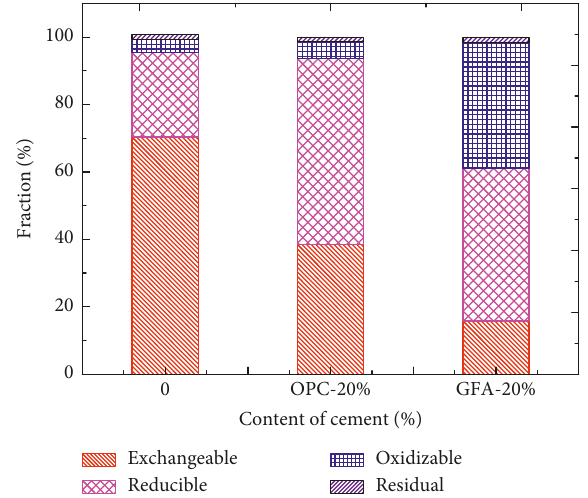
Figure 6: Speciation distribution of Pb in solidified/stabilized soils.